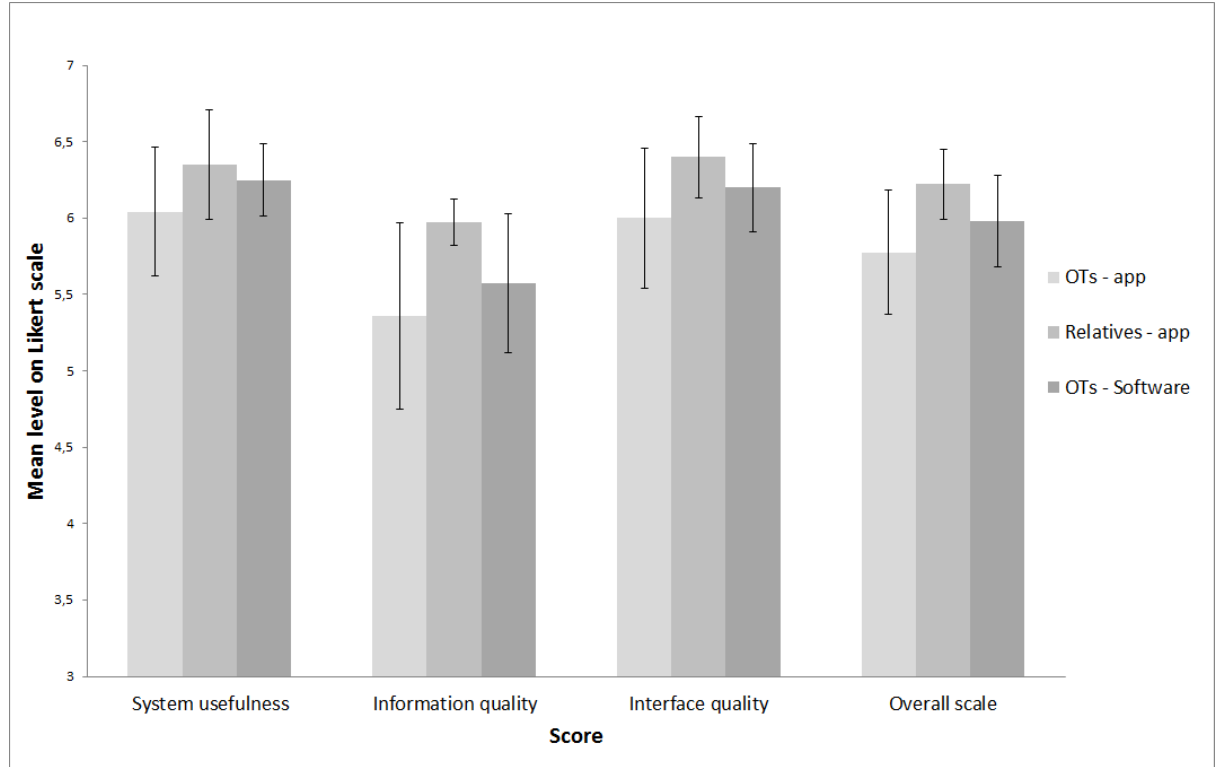
Figure 6. PSSUQ results in the second testing round (mean overall and subscale scores); error bars show standard